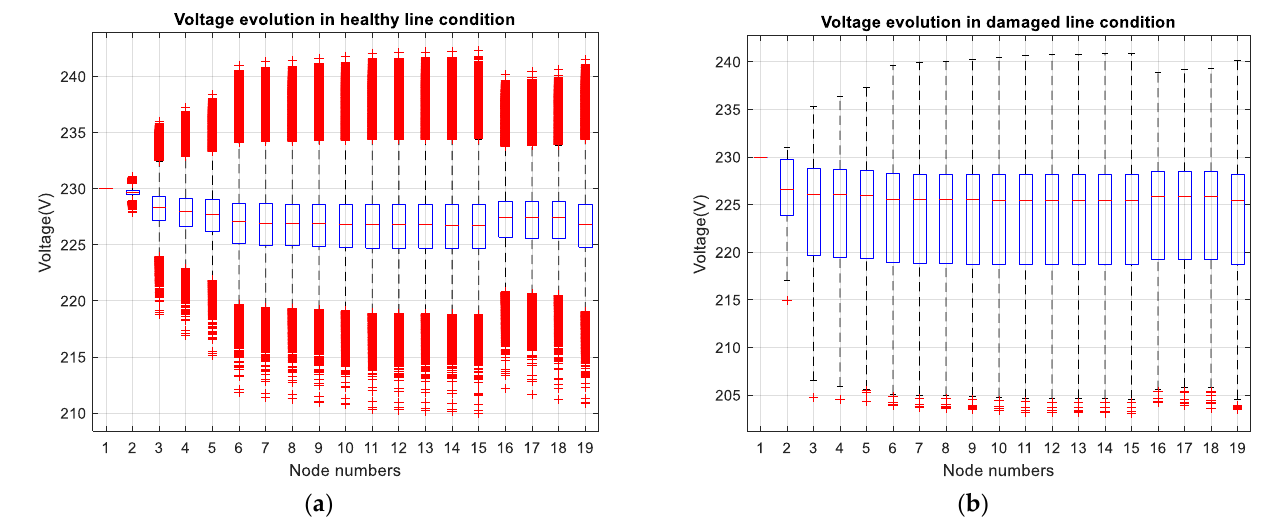
Figure 13. Boxplots of nodal voltages obtained by the load flow calculations ( a ) for feeder in a healthy cable condition, and ( b ) for feeder with a moderately damaged cable located in the line between nodes 2 and 3.